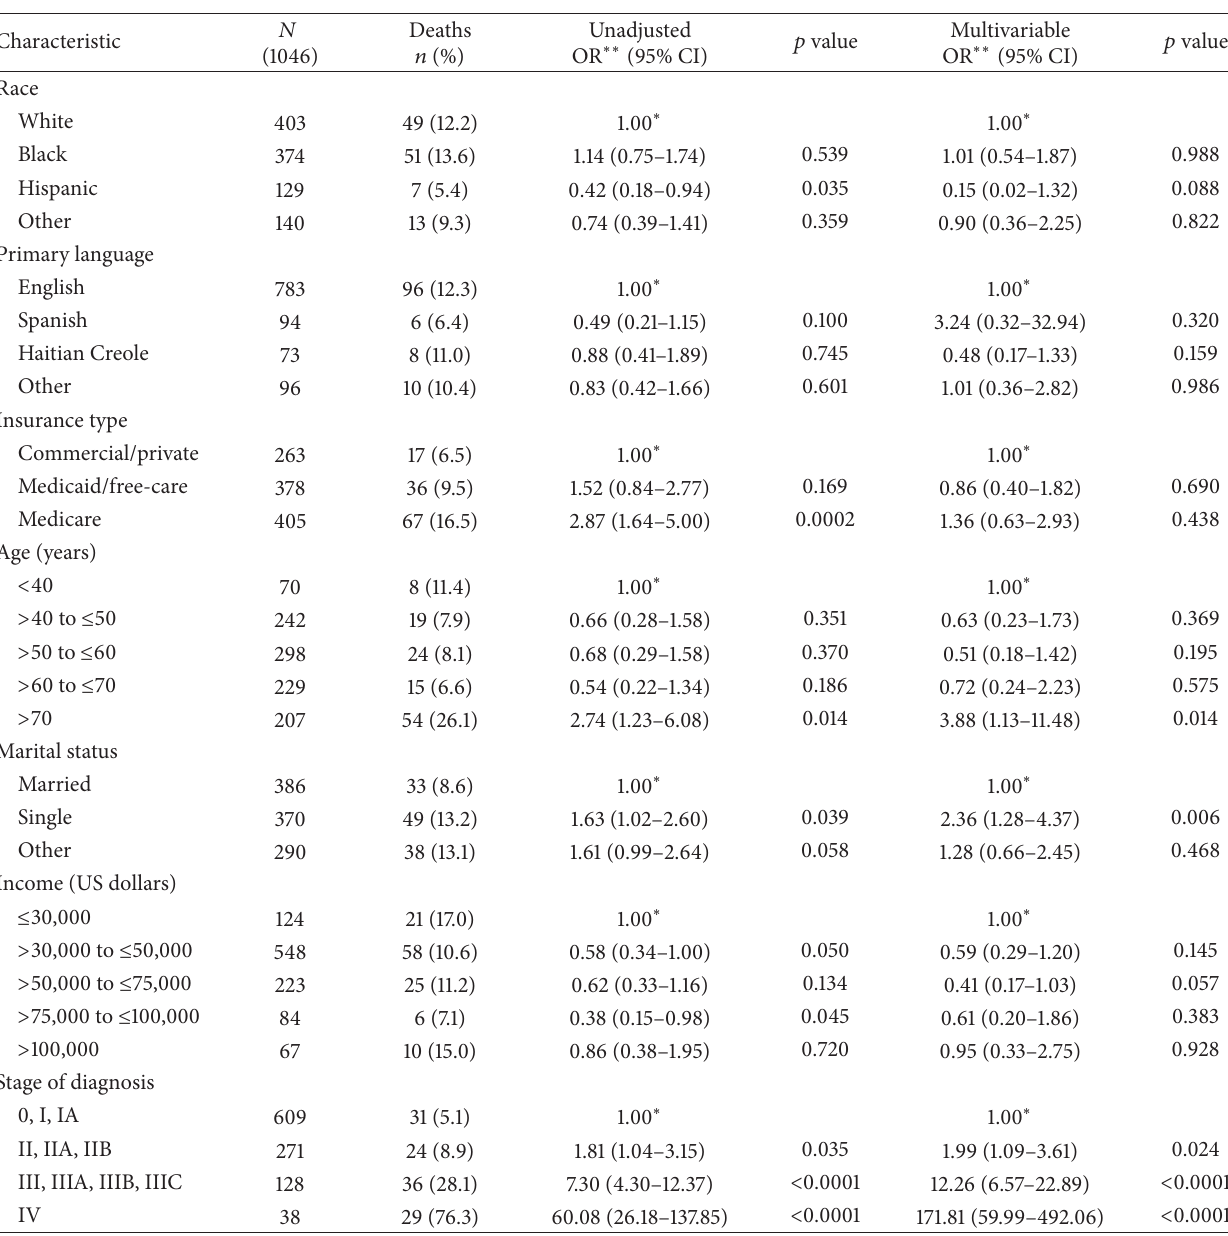
Table 1: Risk of breast cancer mortality by demographic